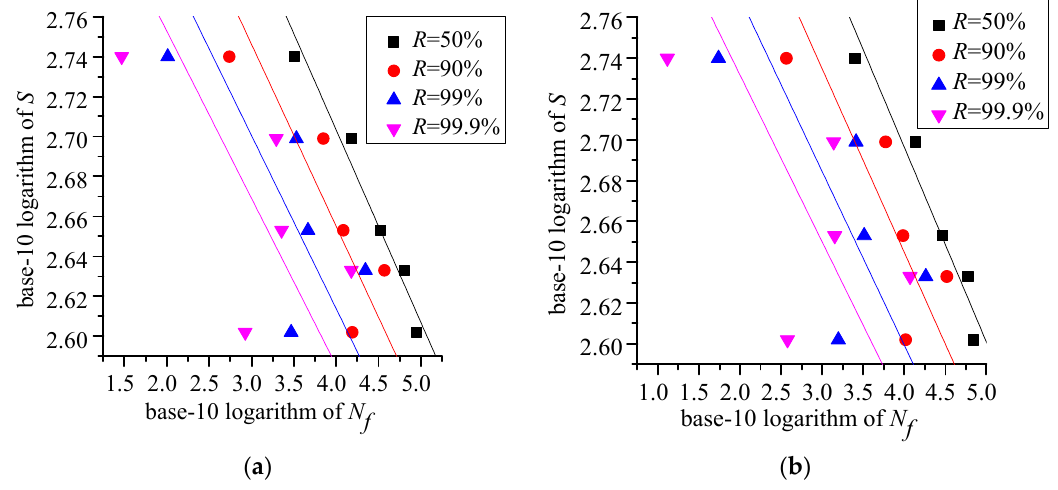
Figure 5. P–S–N curves at tempering temperature 500 °C and confidence levels: ( a ) (cid:2011) = 95% ; ( b ) (cid:2011) = 99% .